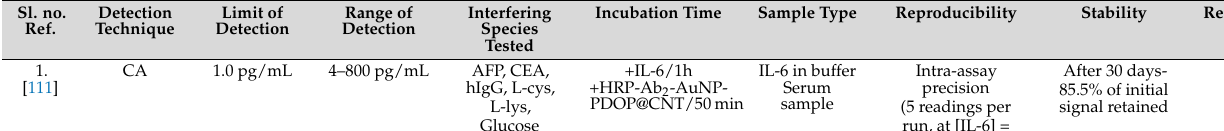
Table 4. Enzyme-labeled immunosensors: Specifications and performance characteristics. Sl. no.